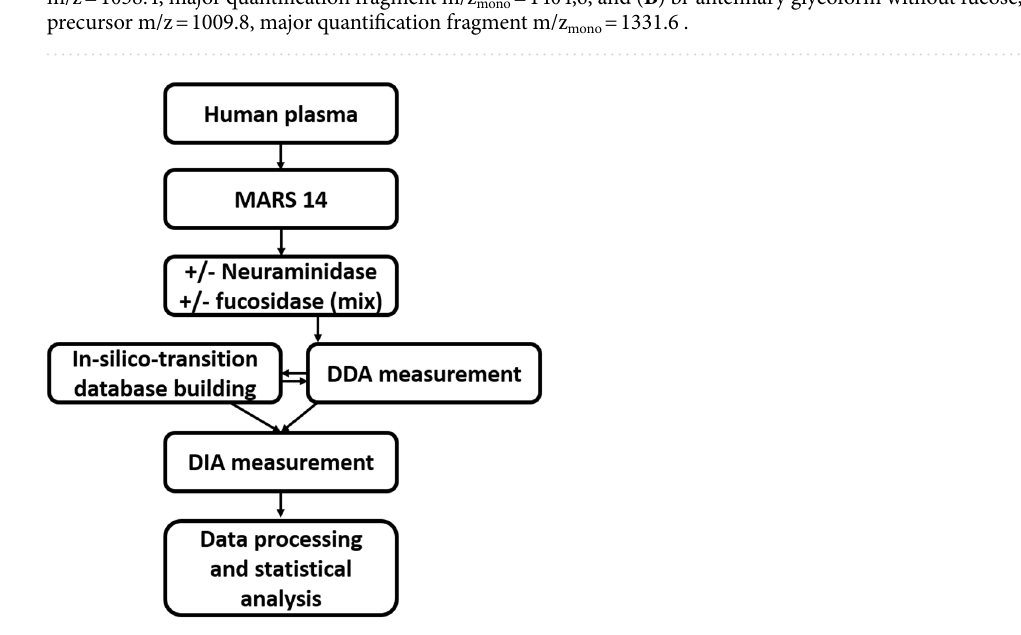
Figure 2. Scheme of workflow of exoglycosidase-assisted data-independent